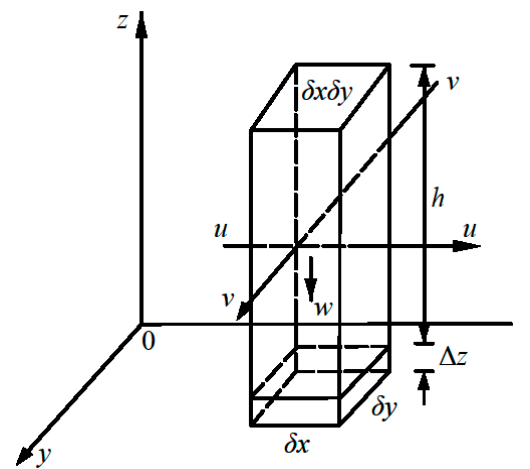
Figure A2. Schematic diagram of horizontal 2D suspended sediment and bed material exchange. The control volume is a unit prism with bottom δ δ x y and the depth h . x and y are coordinates; y is the direction perpendicular to flow; u and v are the velocity components in the x - and y -directions, respectively.